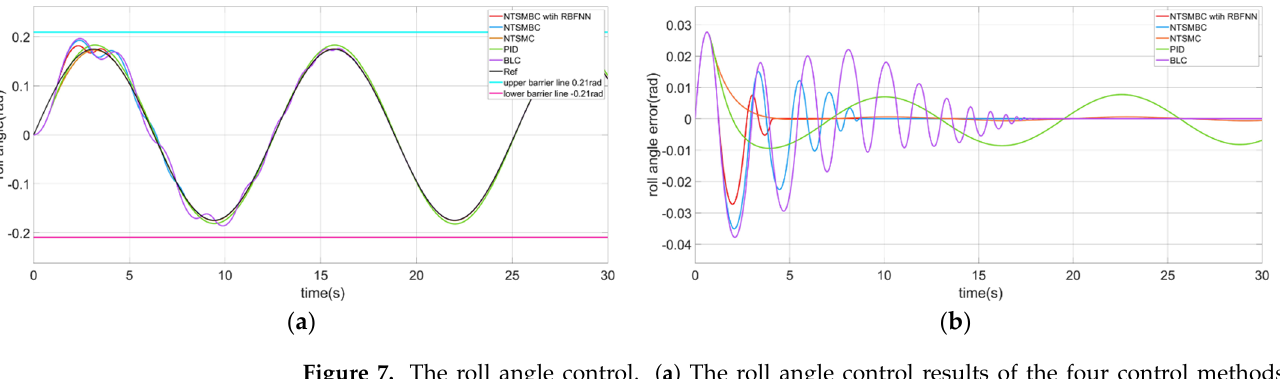
Figure 7. The roll angle control. ( a ) The roll angle control results of the four control methods without the random lumped disturbance. ( b ) The roll angle control errors without the random lumped disturbance.